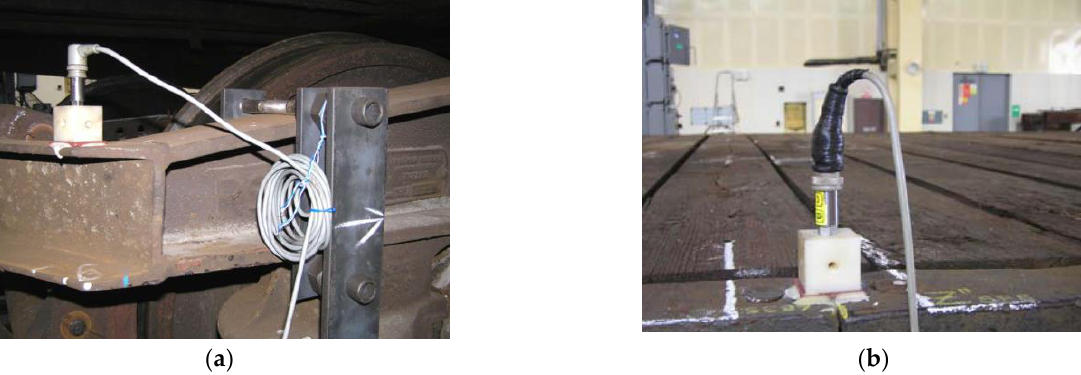
Figure 7. Acceleration sensor location: ( a ) at frame of backward car; ( b ) at platform of car—transversal axis.